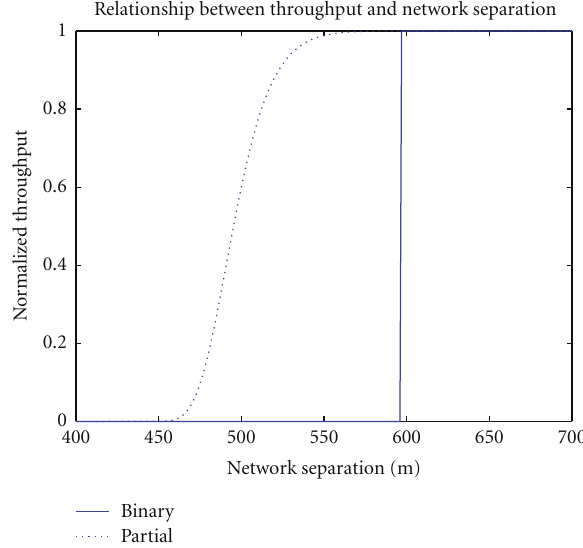
Figure 1: Throughput degradation and network separation.